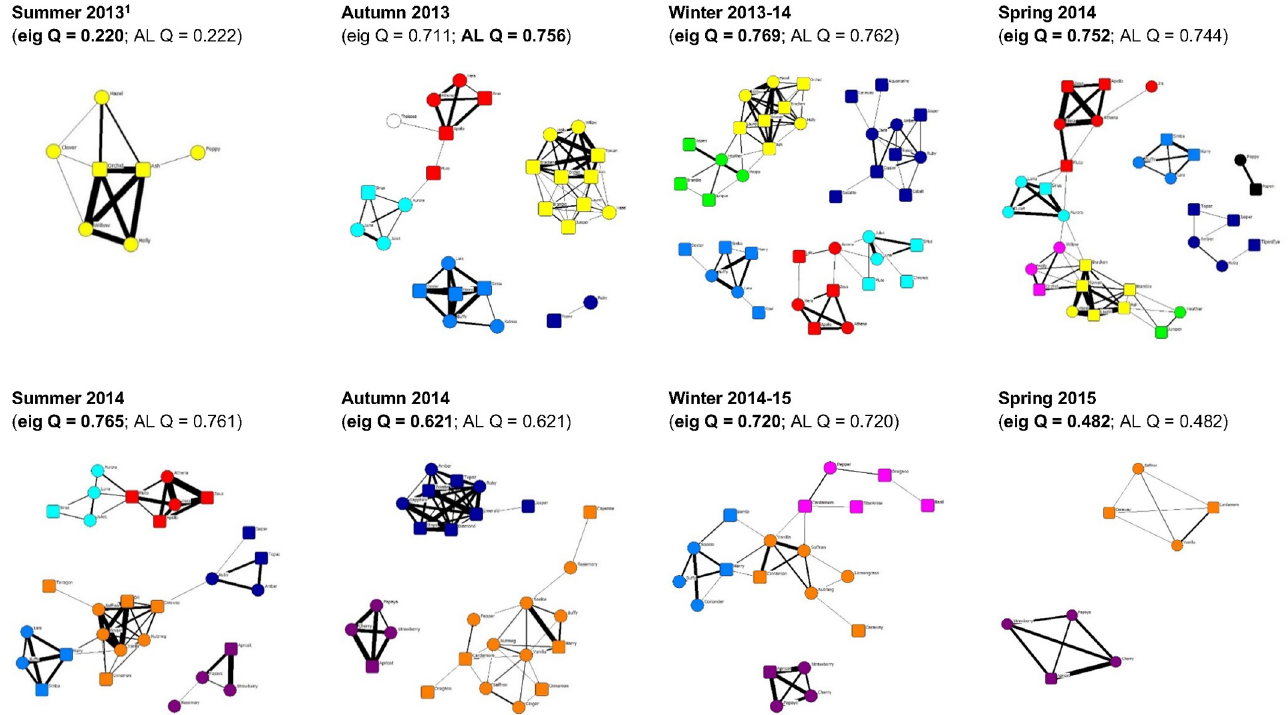
Fig 1. Consistency of communities in each season and year. Edge thickness is proportional to the simple ratio index. Node shapes represent males ( ■ ) and females ( ● ). Eig Q = maximum modularity from eigenvector community detection, AL Q = maximum modularity from average-linkage hierarchical clustering. The communities presented are from the method in bold, based on the highest modularity or the eigenvector method when modularity was the same for both methods. 1 Q < 0.3 indicated the network could not be divided into communities so the full network is presented. The arrow indicates a male that switched communities between seasons.